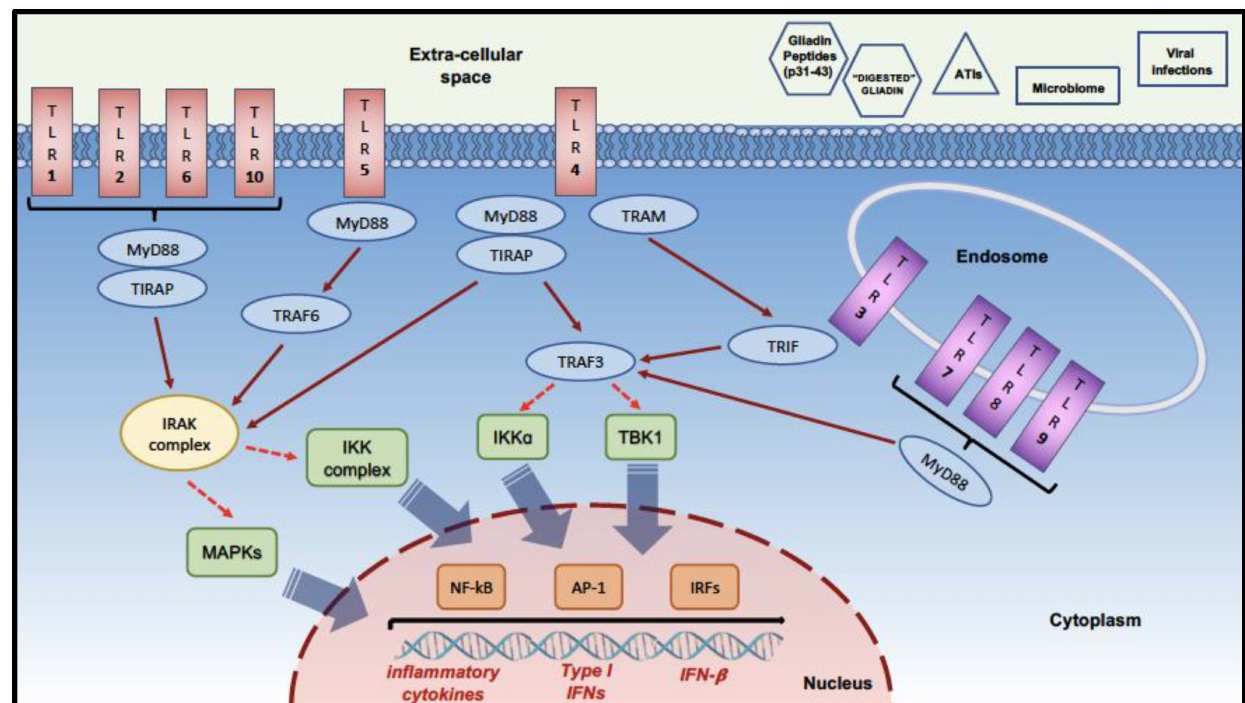
Figure 1. Graphical summary of the TLRs localization/main signaling pathways and potential factors affecting TLRs activation in Celiac Disease. Abbreviations : MyD88, myeloid differentiation primary response 88; TIRAP, toll-interleukin 1 receptor (TIR) domain containing adaptor Protein; TRAF, tumor necrosis factor receptor (TNFR)-associated factors; TRIF, TIR-domain-containing adapter-inducing interferon- β ; MAPKs, mitogen-activated protein kinases; IKK, IkappaB kinase; TBK, TANK (TRAF family member-associated NF-kappa-B activator)-binding kinase; NF-kB, nuclear factor kappa-light- chain-enhancer of activated B cells; AP-1, activator protein 1; IRFs, interferon regulatory factors; ATIs, α -amylase/trypsin